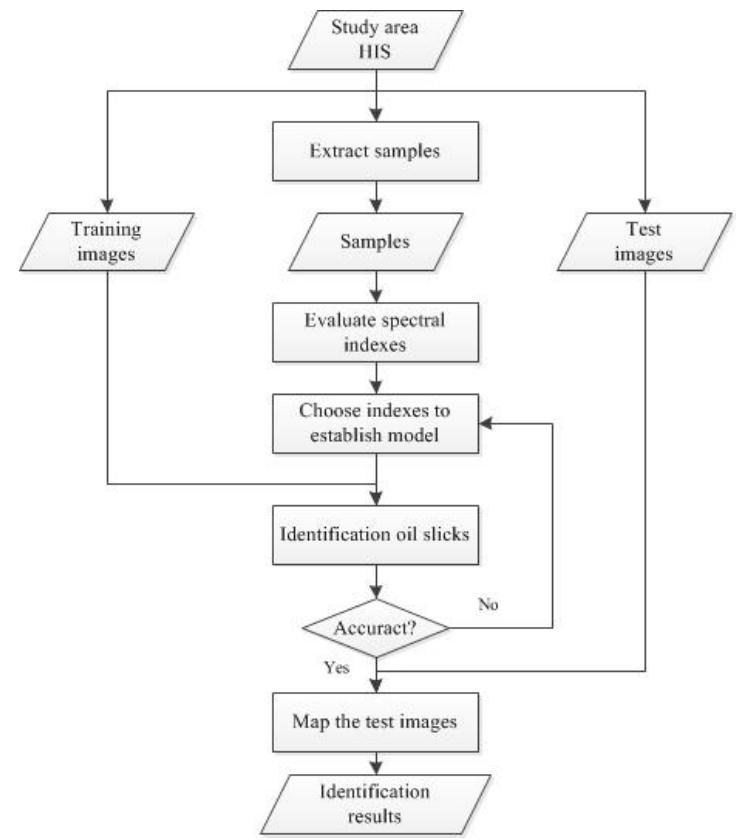
Figure 6. Flow chart of the experimental process (HSI = hyperspectral image).